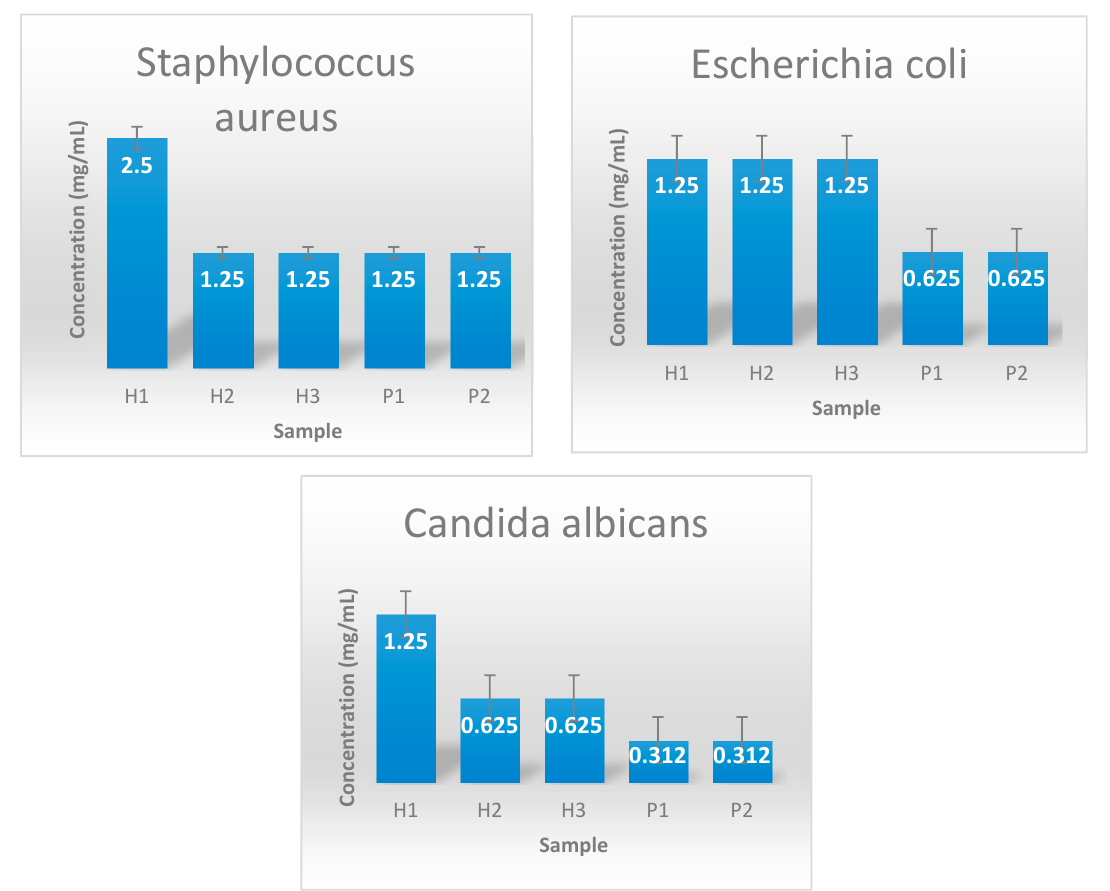
Figure 4. Minimal inhibitory concentration of zinc oxide samples for S. aureus, E. coli and C. albicans.